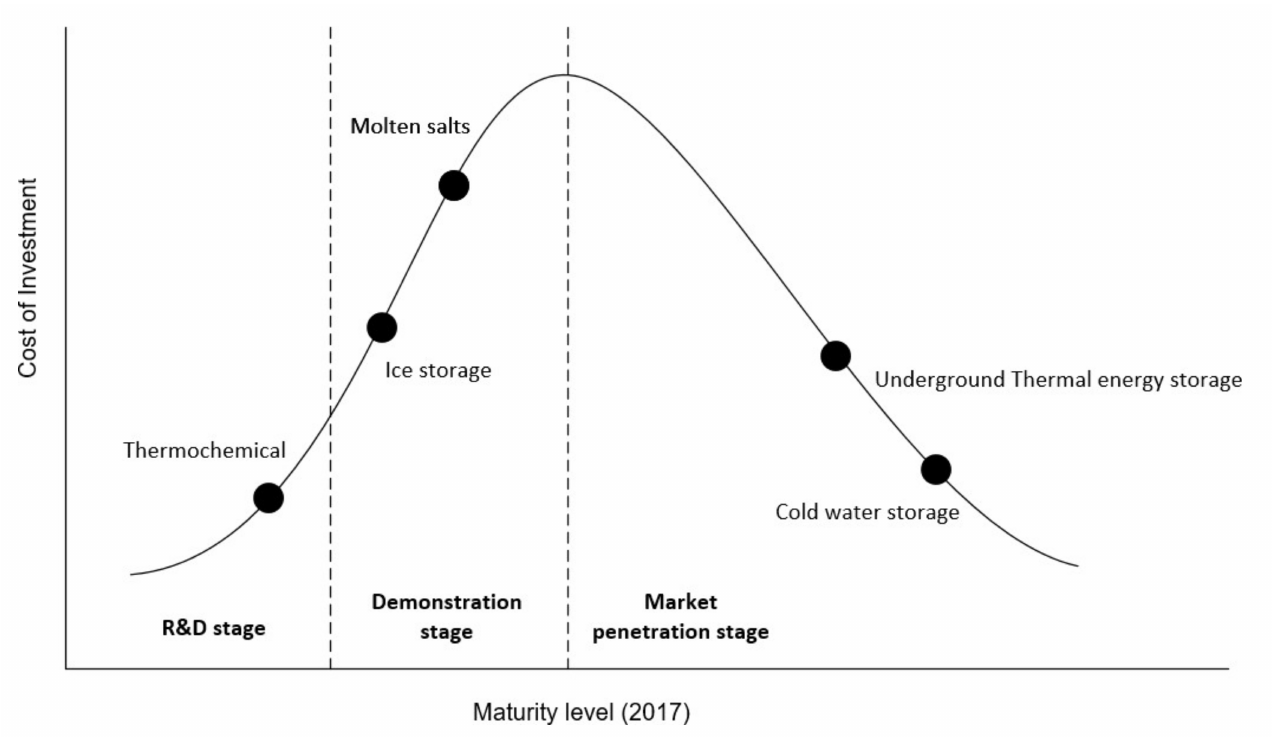
Figure 11. Graph representing the different stages of maturity level of various thermal/cooling energy storage technologies